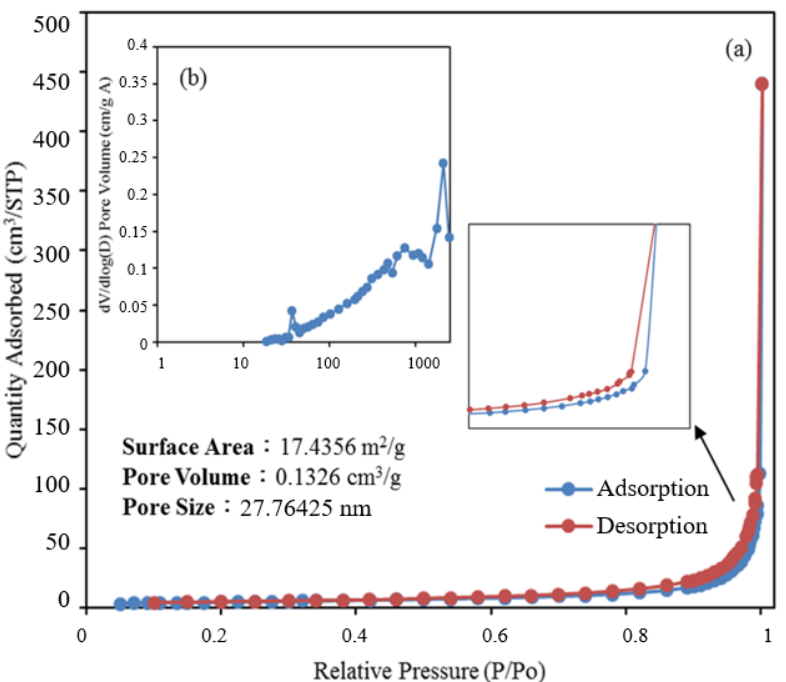
Figure 6. ( a ) Nitrogen adsorption–desorption isotherms and ( b ) the corresponding pore-size distribution curve (inset) for BiOmCln/BiOpIq/g-C3N4 − 20% photocatalyst prepared under a KCl:KI molar ratio of 1:2, a hydrothermal temperature of 250 °C, and a pH of 4.